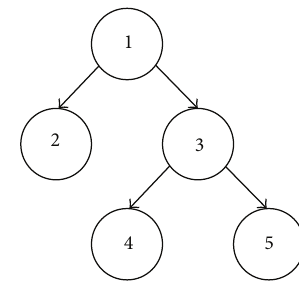
Figure 2: Interaction topology.